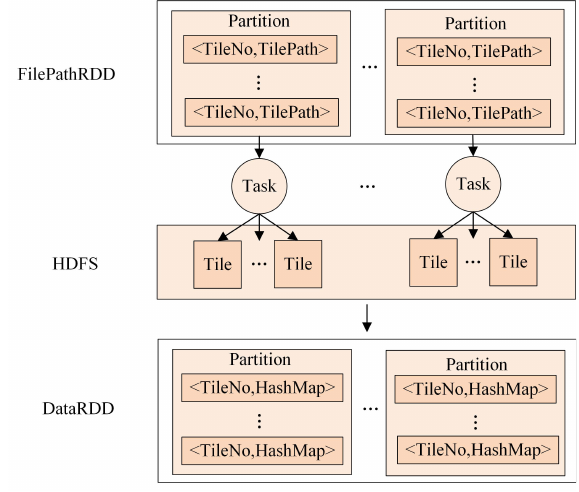
Figure 8. The parallel reading method for multiple tile files.